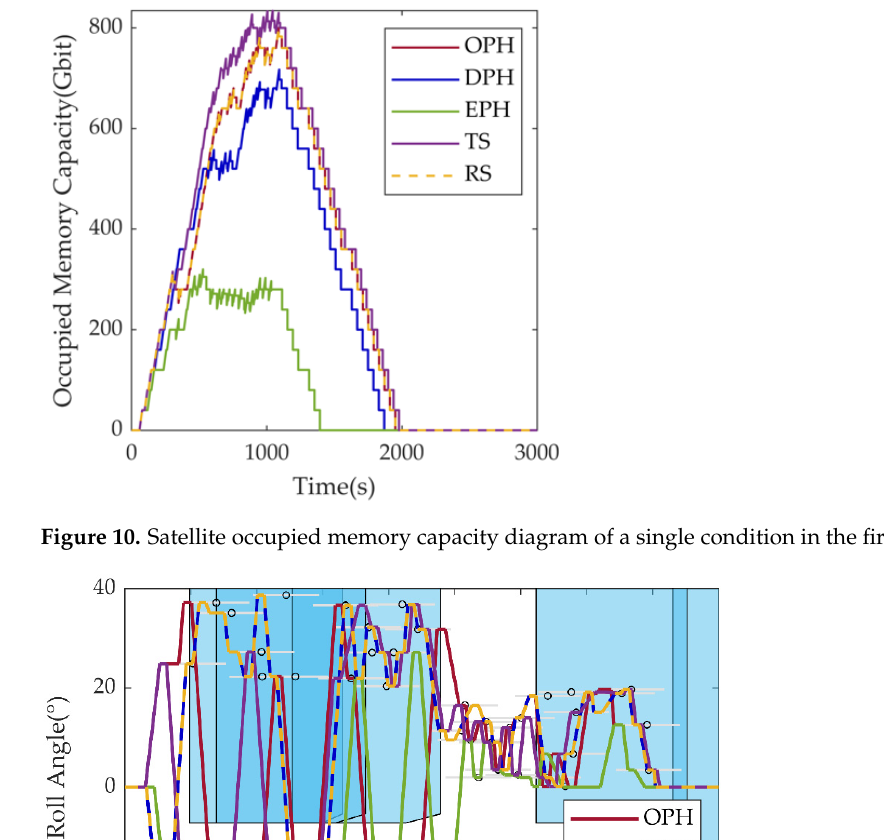
Figure 9. Satellite electrical energy diagram of a single condition in the first group.